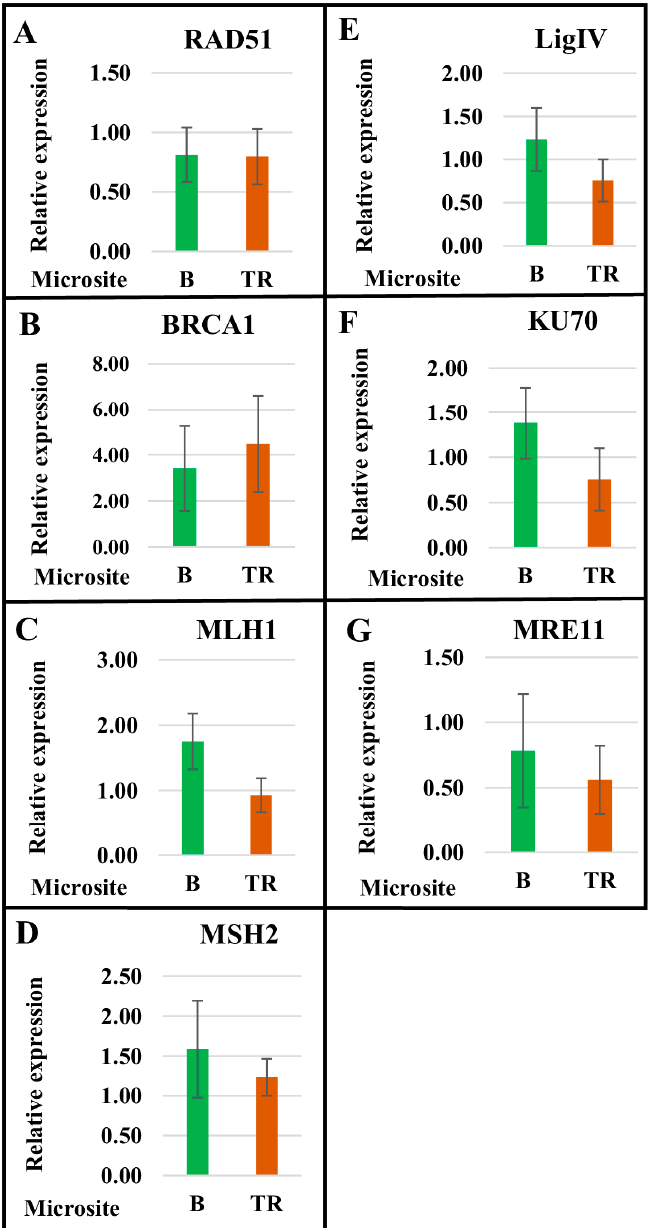
Figure 2. Real-time qPCR analysis of the mean expression of the genes involved in DNA repair pathways in plants from the Basalt (B) and the Terra Rossa (TR) microsites of the Tabigha population. The mean expression values of RAD51 ( A ), BRCA1 ( B ), MLH1 ( C ), MSH2 ( D ), LigIV ( E ), KU70 ( F ), and MRE11 ( G ) are represented for the B and TR microsites. Standard deviation bars are shown.